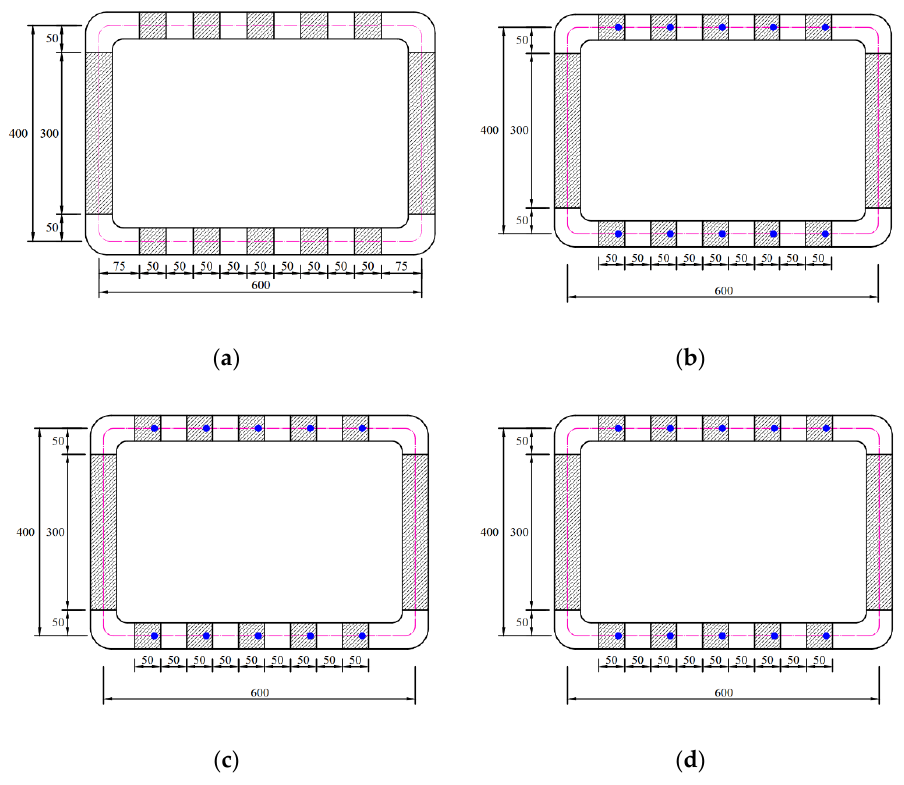
Figure 5. Details of the locations of reinforcements and extractions in mortar specimens. ( a ) S1; ( b )